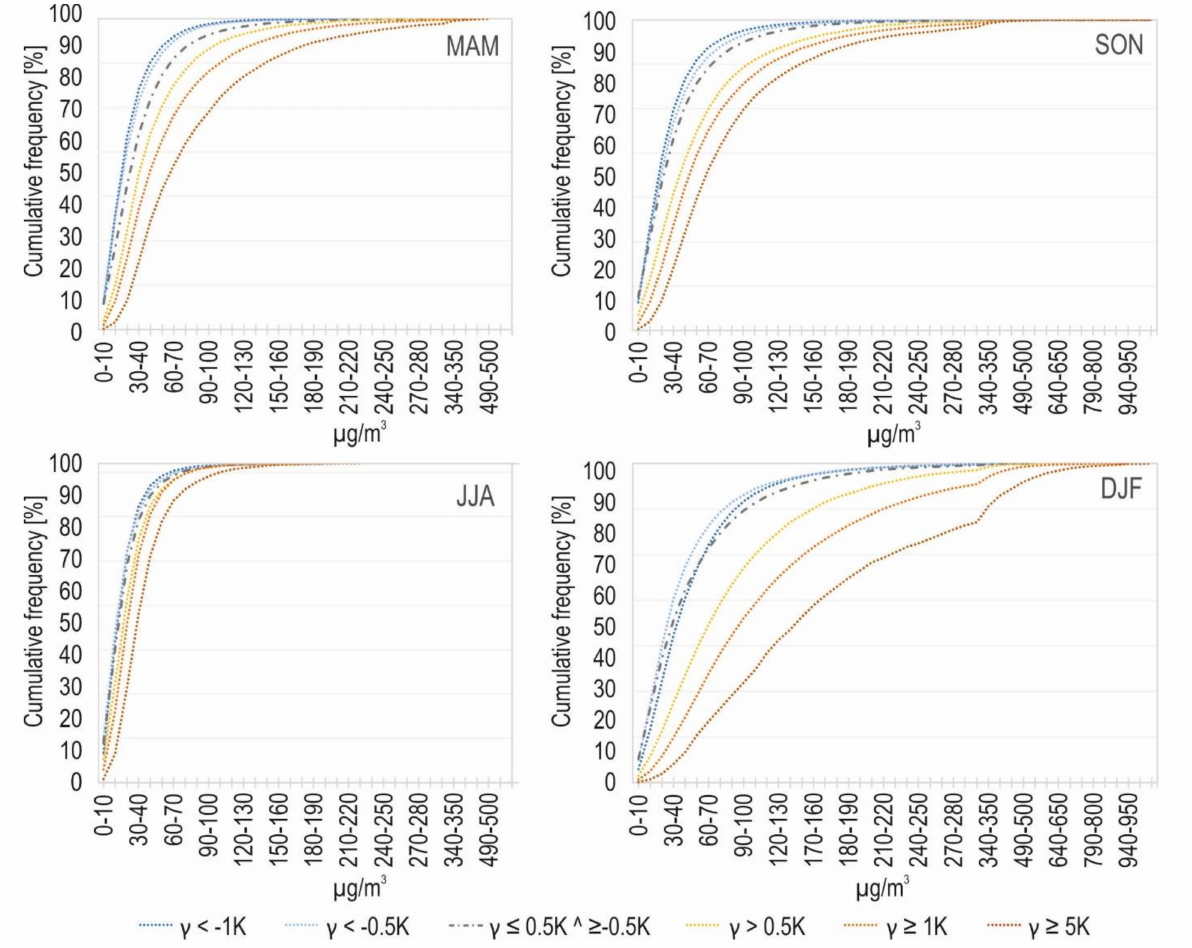
Figure 8. Cumulated frequency of hourly PM 10 concentration [ µ g/m 3 ] depending on air temperature gradients γ from seasonal